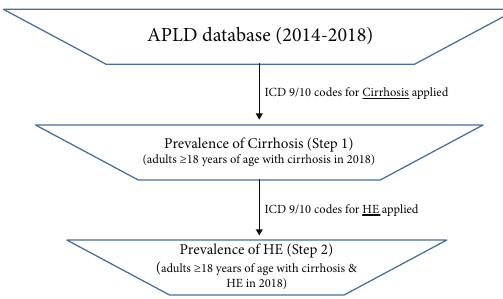
Figure 1: Estimation of HE prevalence in patients with cirrhosis.